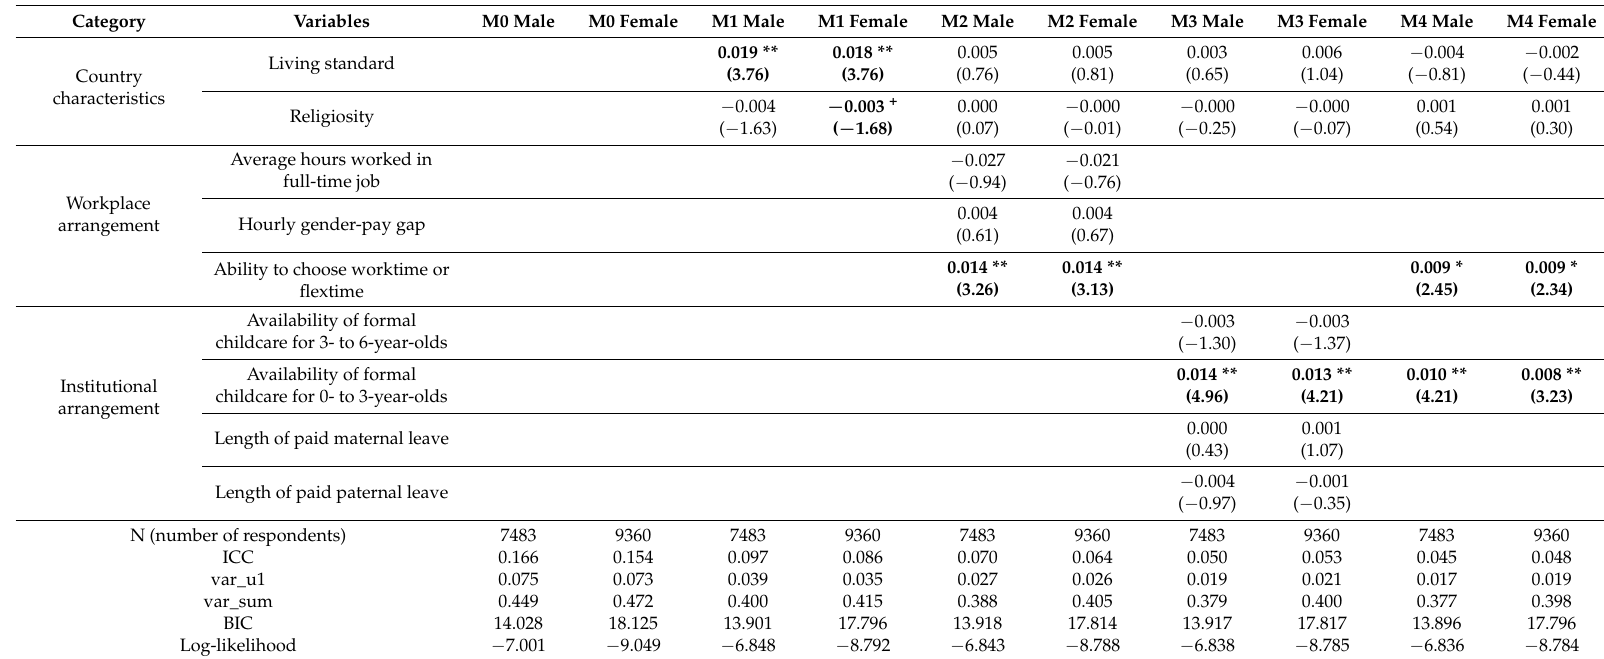
Table 5. Macro-level